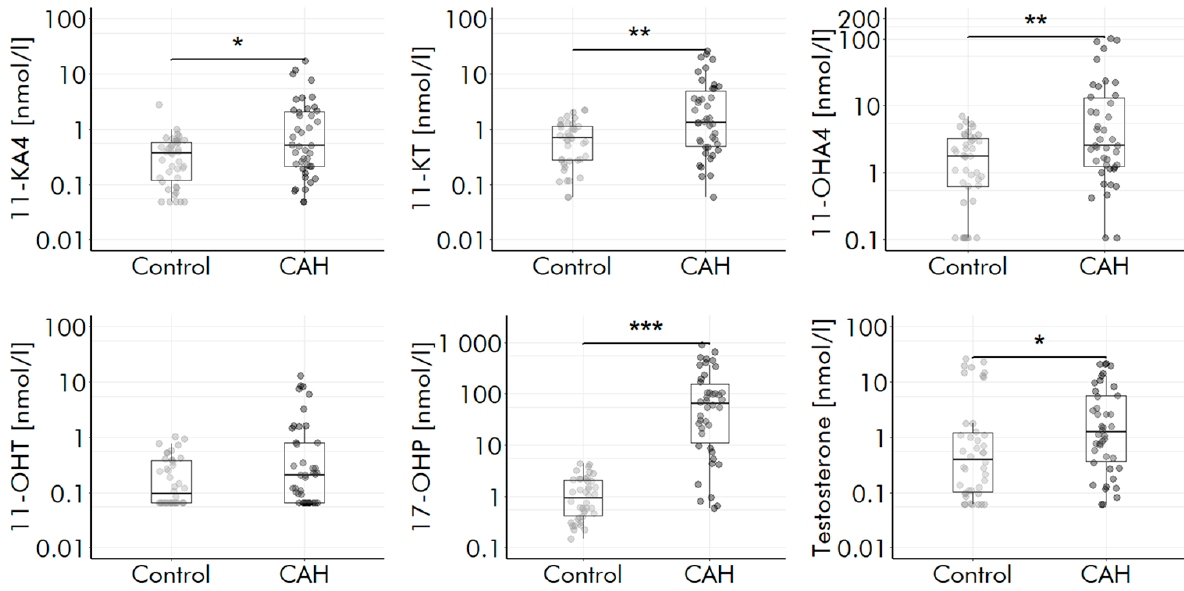
Figure 4. Levels of 17-OHP, testosterone and 11-OAs are elevated in CAH. Boxplots show median and interquartile range, whiskers indicate 95% confidence interval; * p < 0.01, ** p <0.05, *** p < 0.001. CAH, congential adrenal hyperplasia; 11-KA4, 11-ketoandrostenedione; 11-KT, 11-ketotestosterone; 11-OHA4, 11 β -hydroxyandrostenedione; 11-OHT, 11 β -hydroxytestosterone; 17-OHP, 17 α -hydrox- yprogesterone. Accordingly, ratios of A/11-OHT ( p = 0.004), DHEAS/11-OAs ( p < 0.001), T/11-OHT ( p = 0.042) were decreased in CAH patients, reflecting a higher adrenal versus gonadal androgen synthesis. 11-OA levels in the 42 healthy individuals were comparable to pub- lished concentration levels for 11-OAs (Table S3).